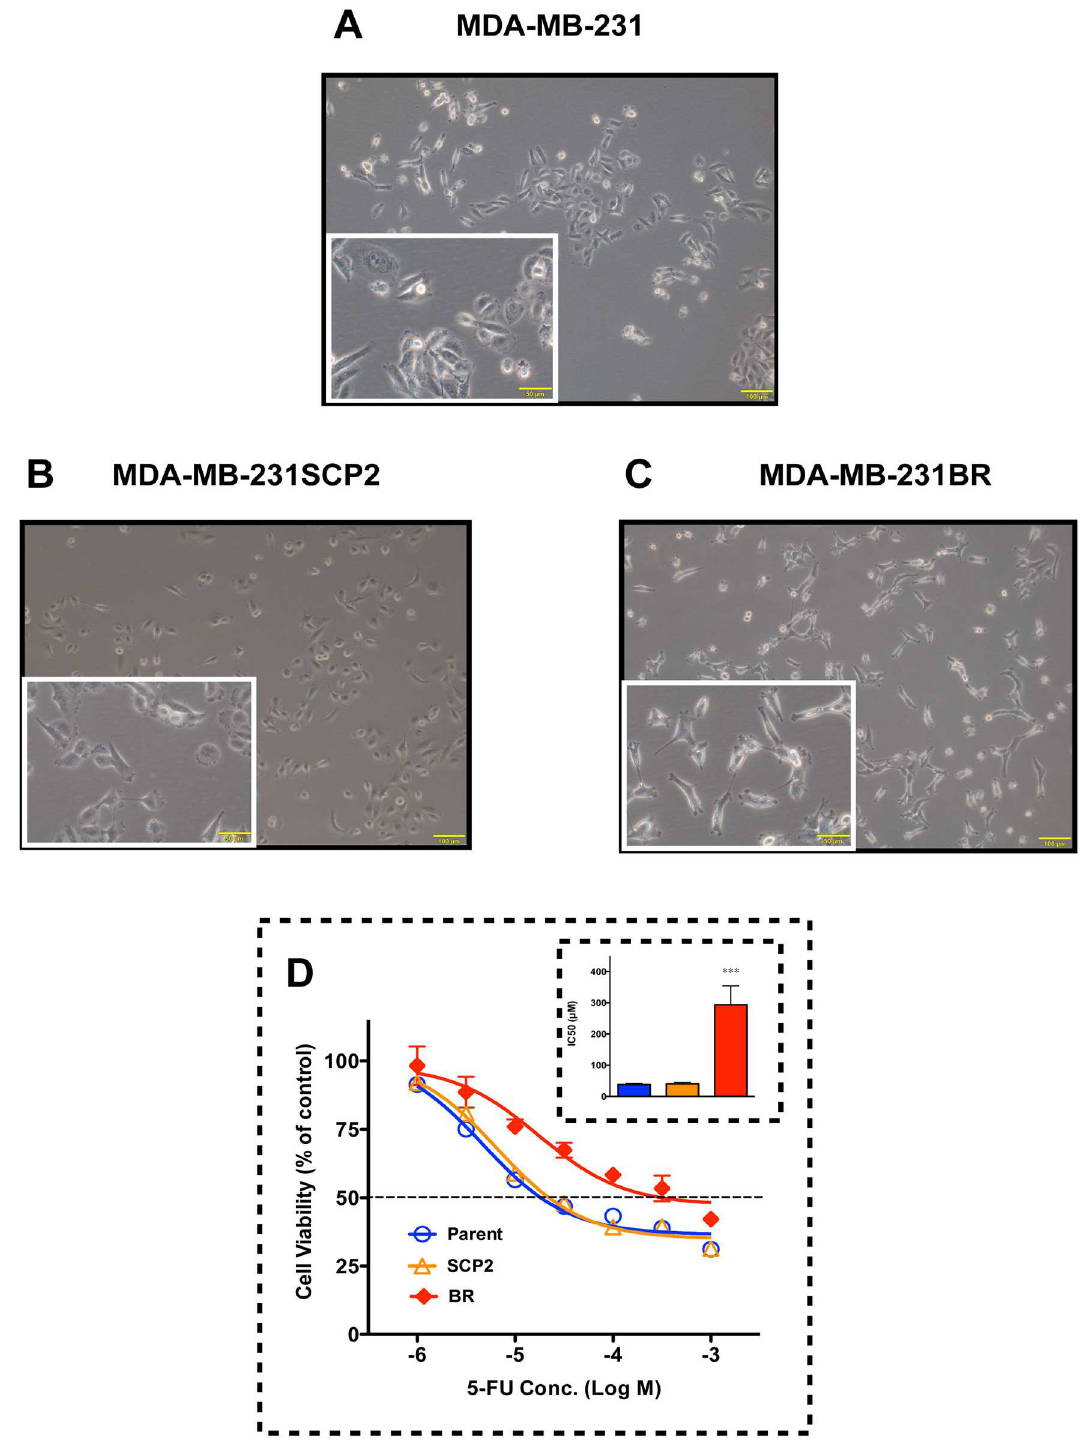
Fig 1. Morphological differences among MDA-MB-231 cell lines, and their cytotoxic response to 5-FU. (A-C) Photomicrographs of (A) MDA-MB-231, (B) MDA-MB-231SCP2, and (C) MDA-MB-231BR. Scale bar, 100 μ m. Scale bars in the insets indicate 50 μ m. (D) Cytotoxicity of 5-FU toward MDA-MB-231 (Parent), MDA-MB-231SCP2 (SCP2), and MDA-MB-231BR (BR). The inset shows the IC 50 of 5-FU against each cell line. Data represent the mean with SEM of at least six independent samples ( *** p < 0.001 vs . Parent and